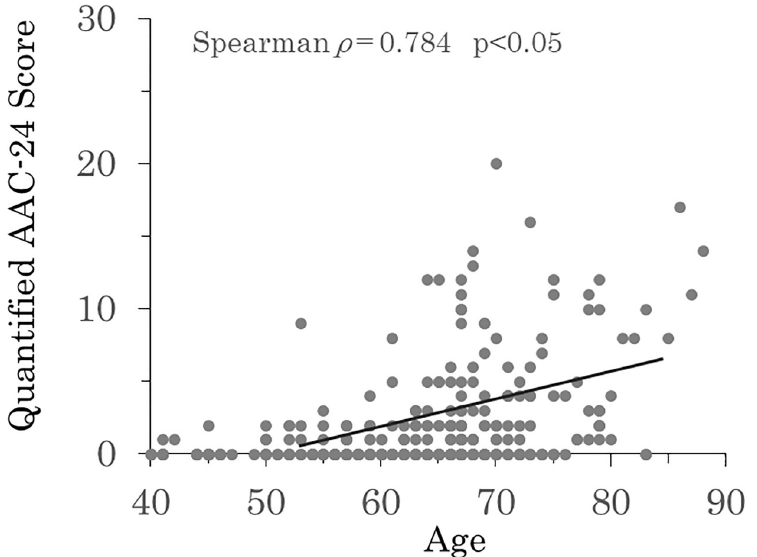
Fig 6. Relationship between AAC-24 scores and age (Spearman ρ = 0.784, p <